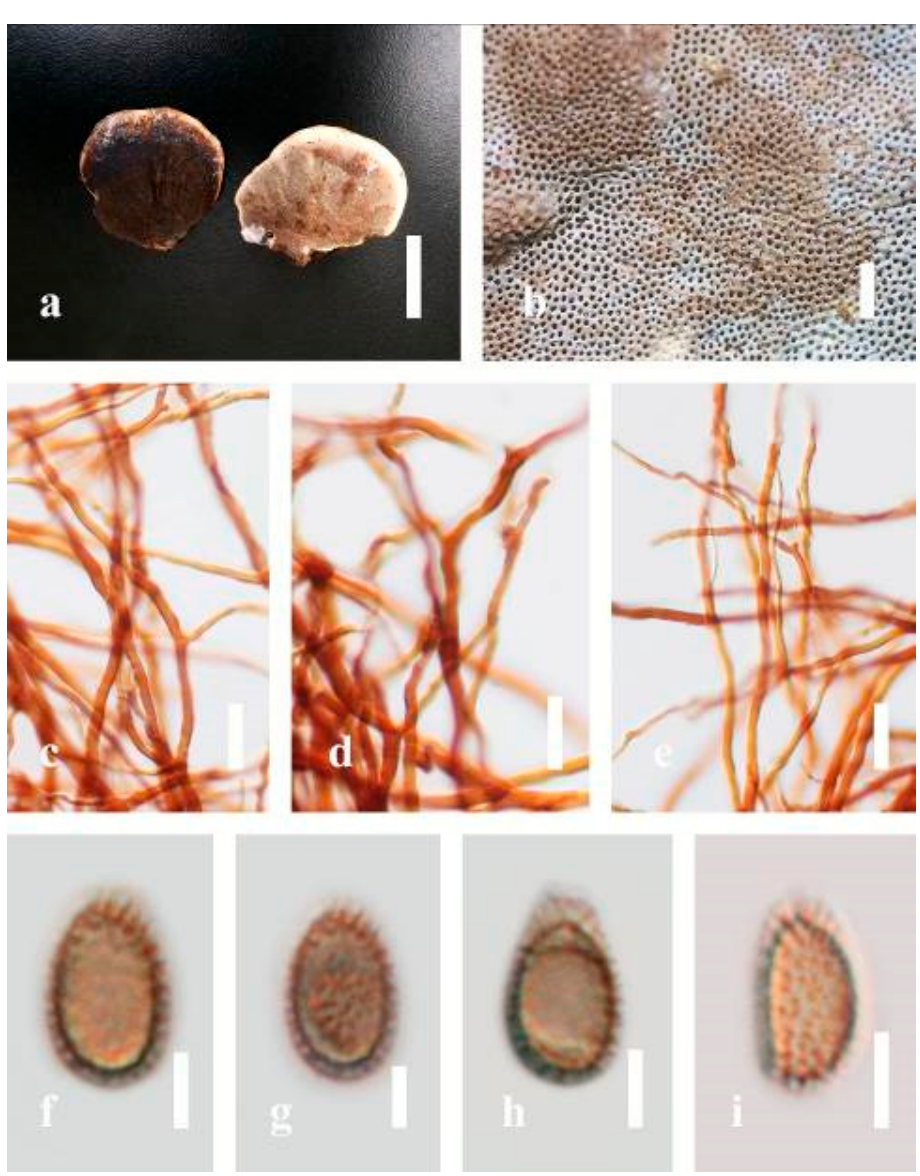
Figure 19. Morphology characteristics of Ganoderma hoehnelianum (MFLU 19 ‐ 2168): ( a ) young ba ‐ sidiomes; ( b ) pore characteristics; ( c – e ) context hyphae in Melzer’s reagent; ( f – i ) basidiospores. Scale bars: ( a ) = 2 cm, ( b ) = 1000 μ m, ( c – e ) = 20 μ m, ( f – i ) = 5 μ m.